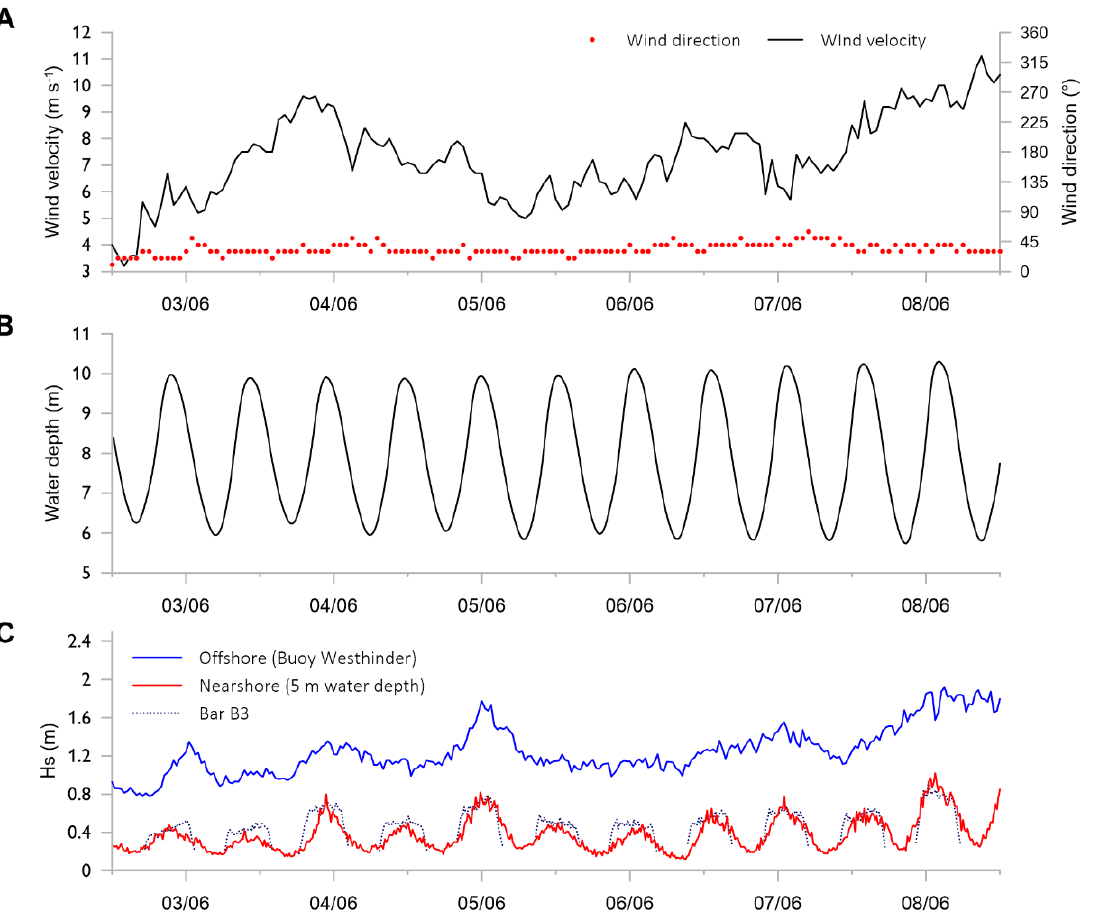
Figure 3. Time series of wind data and hydrodynamic parameters recorded from 2 to 8 June 2013 on bar B3 on the lower beach (see Figure 2D for location) and offshore of the studied beach. ( A ) Wind velocity and direction recorded at the Dunkirk weather station; ( B ) water level changes recorded in 5 m water depth (relative to Hydrographic Datum); ( C )